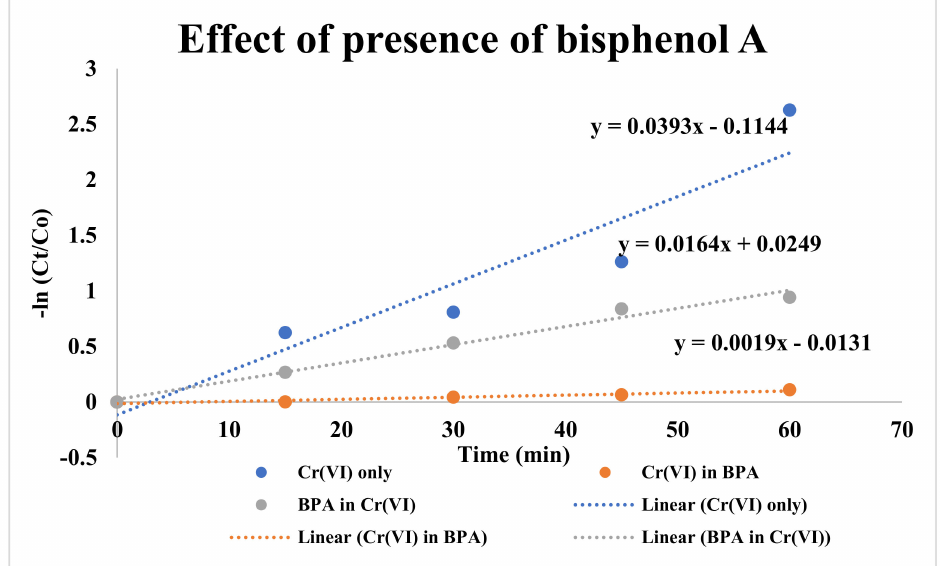
Figure 10. The photocatalytic reduction of Cr(VI) in the presence and absence of bisphenol